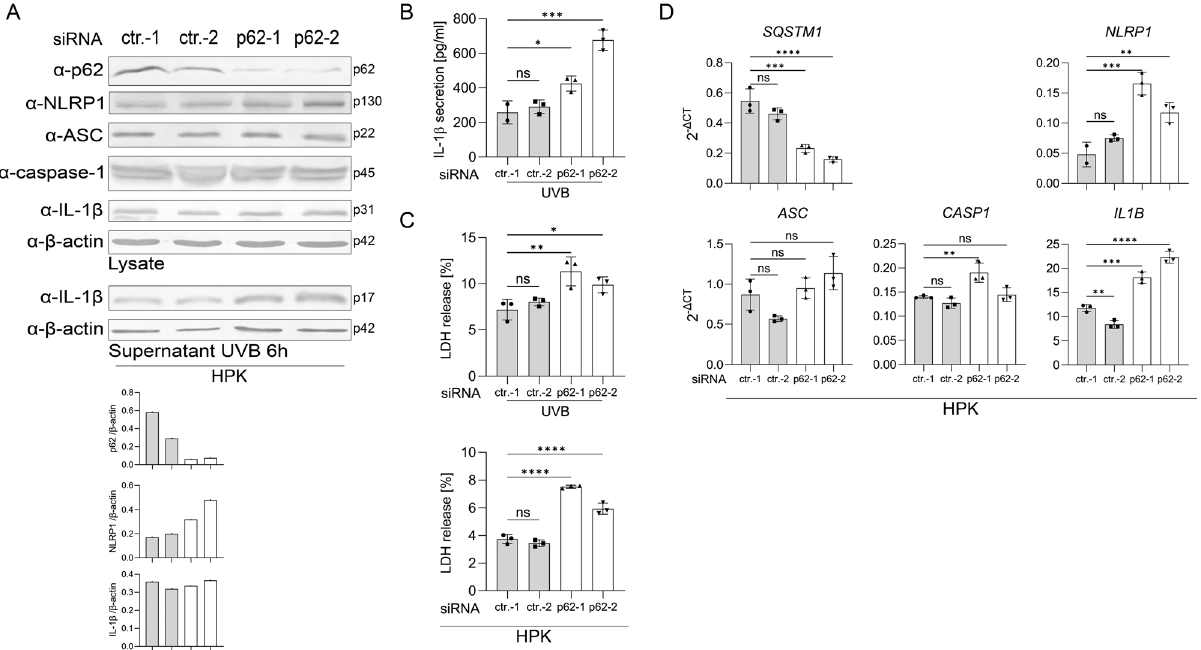
Fig. 3 p62 knockdown supports in fl ammasome activation in HPKs. A – D HPKs were transfected with two control siRNAs (ctr.-1, ctr.-2) or two different siRNAs targeting p62 mRNA (p62-1, p62-2). A Western blots of lysates of mock-treated HPKs with a quanti fi cation of the band corresponding to p62, NLRP1, and IL1 β normalized to β -actin (lower panel), and of supernatant 6 h after UVB irradiation. B ELISA measurement of IL-1 β in the supernatant 6 h after UVB irradiation. C Cell lysis determined by LDH assay 6 h after UVB irradiation (upper panel) or upon mock- treatment (lower panel). D Expression of mRNA of the indicated genes in mock-treated cells determined by qPCR. Data are represented as mean ± SD of three experiments using one-way analysis of variance with Dunnett ’ s multiple comparison test ( N = 3) ( B – D ) or are representative of at least three independent experiments ( A ). (**** P < 0.001, *** P ≤ 0.001, ** P ≤ 0.01, and * P ≤ 0.05, ns = not signi fi